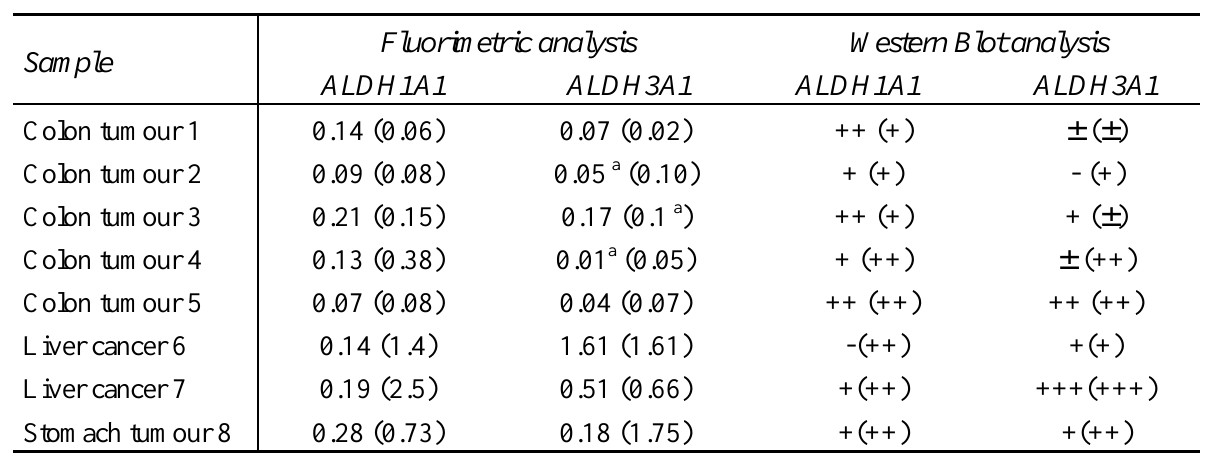
Table 1. Specific activities of ALDH isozymes, in units per gram protein, determined in tumour samples, compared to those found in the surrounded tissue (in parentheses), and to Western Blot